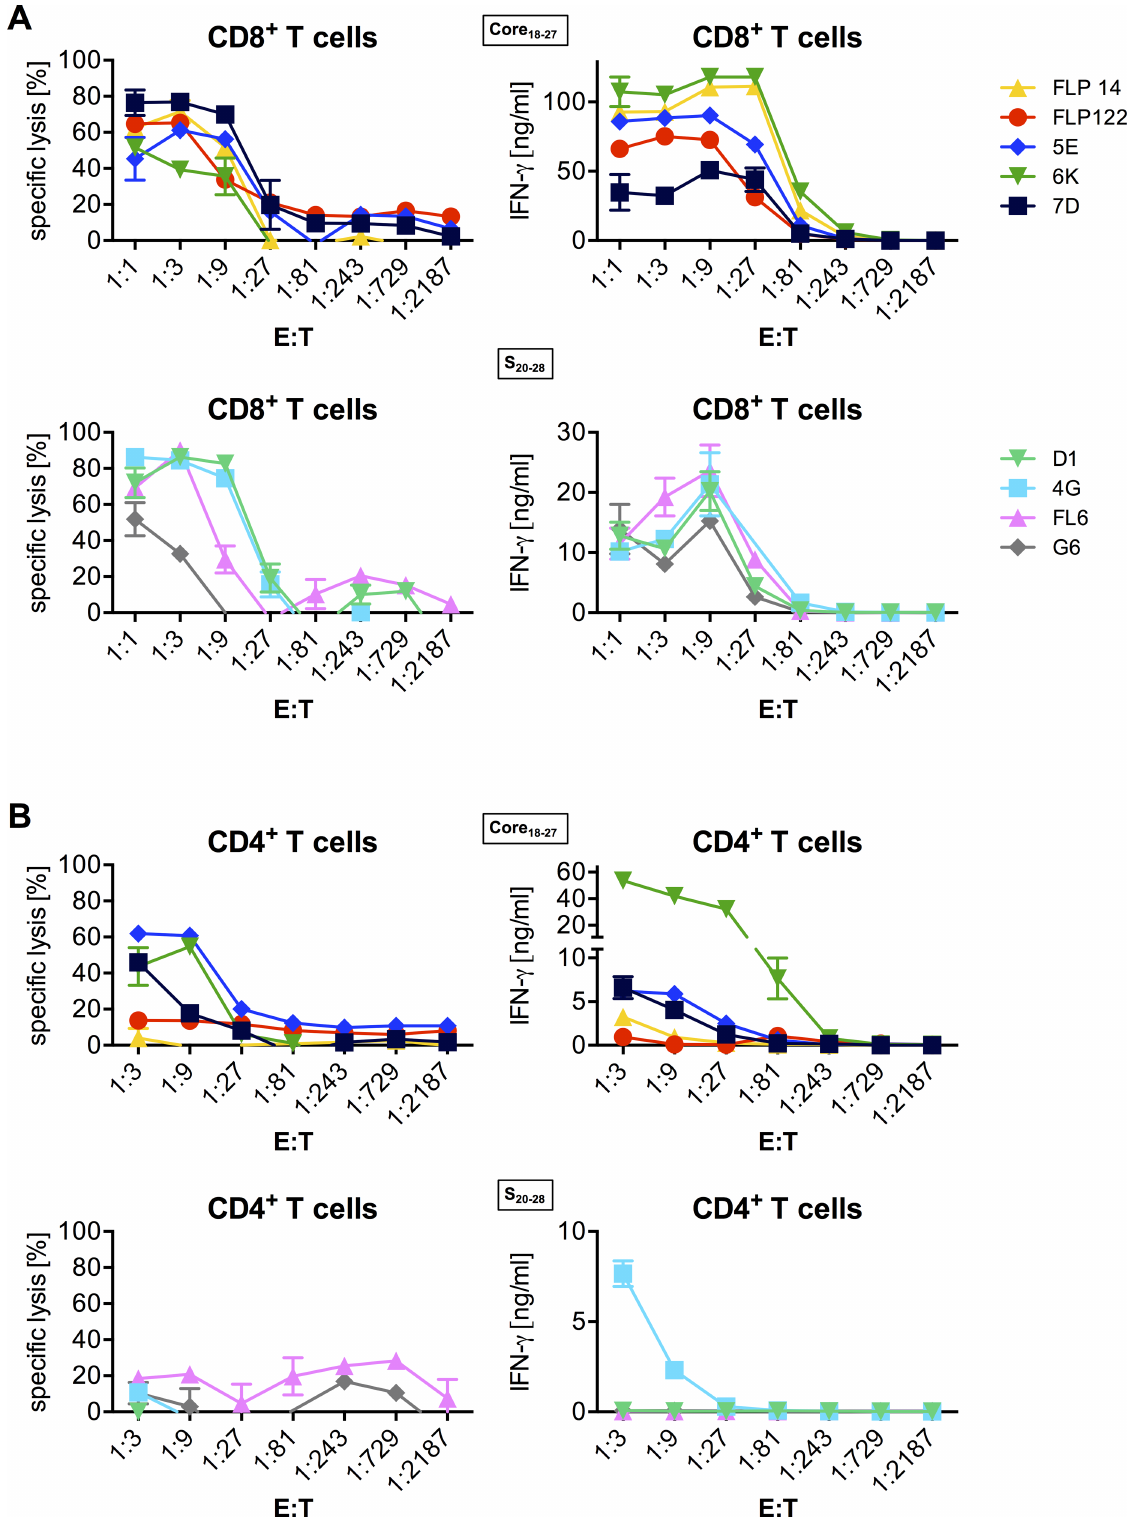
Fig 6. Recognition of endogenously processed HBV peptides by TCR-transduced T cells. After retroviral transduction with respectiveTCRs, CD8 + and CD4 + T cells were separated by MACS. Specific lysis of HBV-replicating HepG2.2.15 hepatomacells